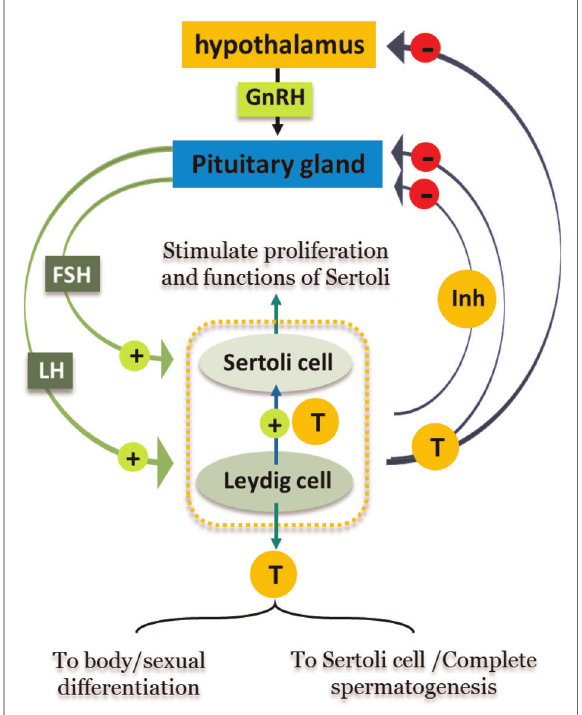
FIGURE 1 Hormonal regulation of spermatogenesis. Male reproductive cycles are controlled by interactions between secreted hormones from the anterior pituitary gland, hypothalamus and testis. The hypothalamus releases GnRH, hence stimulating the anterior pituitary gland to secret LH and FSH into the circulatory system. FSH stimulates Sertoli cells in the testis to begin spermatogenesis. Thus, when sperm counts increase Sertoli cells secrete inhibitors (Inh) into the blood that have a negative feedback on the hypothalamus, inhibiting the release of GnRH. LH stimulates Leydig cells to produce and secrete the hormone testosterone ( T ) into blood. When testosterone levels increase, it affects hypothalamus/ pituitary gland by a negative feedback mechanism, thus inhibiting the production of LH, FSH, and